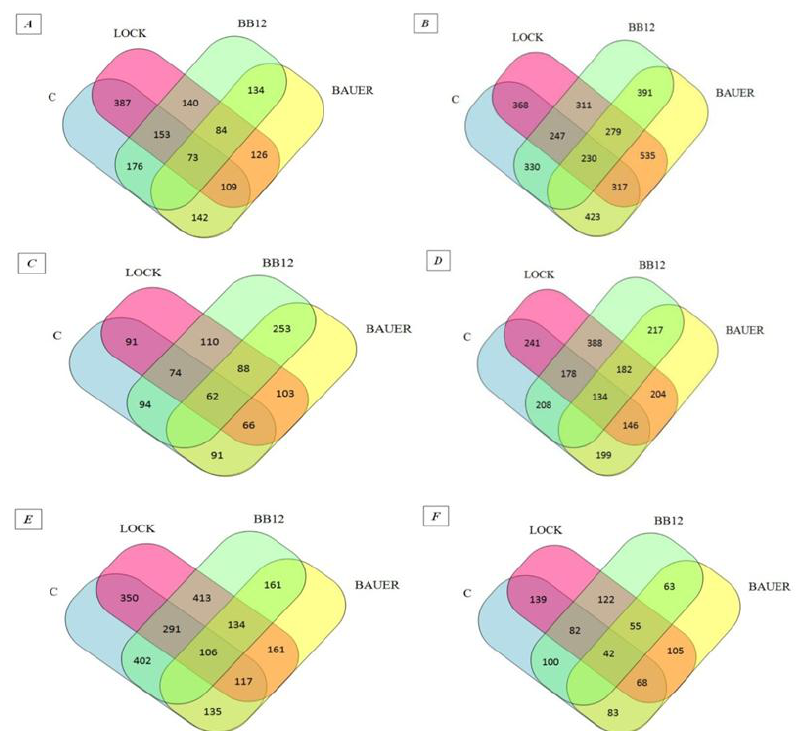
Figure 1. Venn diagrams of peptides obtained from dry-cured pork loins after digestion and simulated absorption: ( A ) peptides obtained from WSF after 28 days of aging, ( B ) peptides obtained from SSF after 28 days of aging, ( C ) peptides obtained from WSF after 90 days of aging, ( D ) peptides obtained from SSF after 90 days of aging, ( E ) peptides obtained from WSF after 180 days of aging, ( F ) peptides obtained from SSF after 180 days of aging. LOCK, sample inoculated with Lactobacillus rhamnosus LOCK900; BAUER, sample inoculated with Lactobacillus acidophilus Bauer Ł0938; BB12, sample inoculated with Bifidobacterium animalis ssp. lactis BB-12.